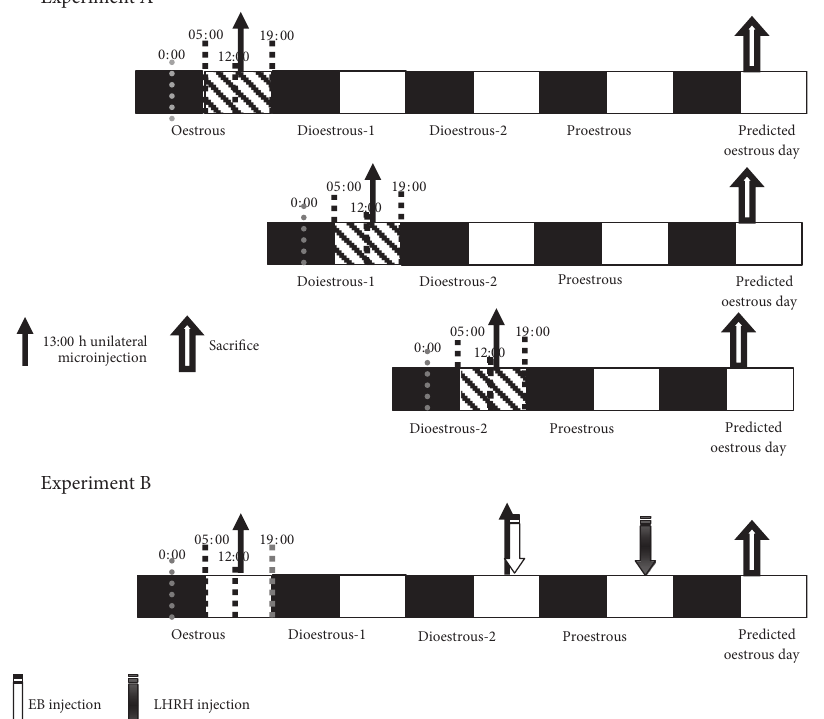
Figure 2: Schematic representation of the experiments A and B. Experiment A: experimental design for unilaterally microinjecting drugs (PZP, MTC, or vehicle) on the left or right side of the POA-AHA region on the day of oestrous, dioestrous-1, or dioestrous-2. Experiment B: experimental design for re-establishing the hypothalamic signal through the replacement of LH-releasing hormone (LHRH) or oestradiol benzoate (EB). All animals were sacri fi ced on the predicted day of